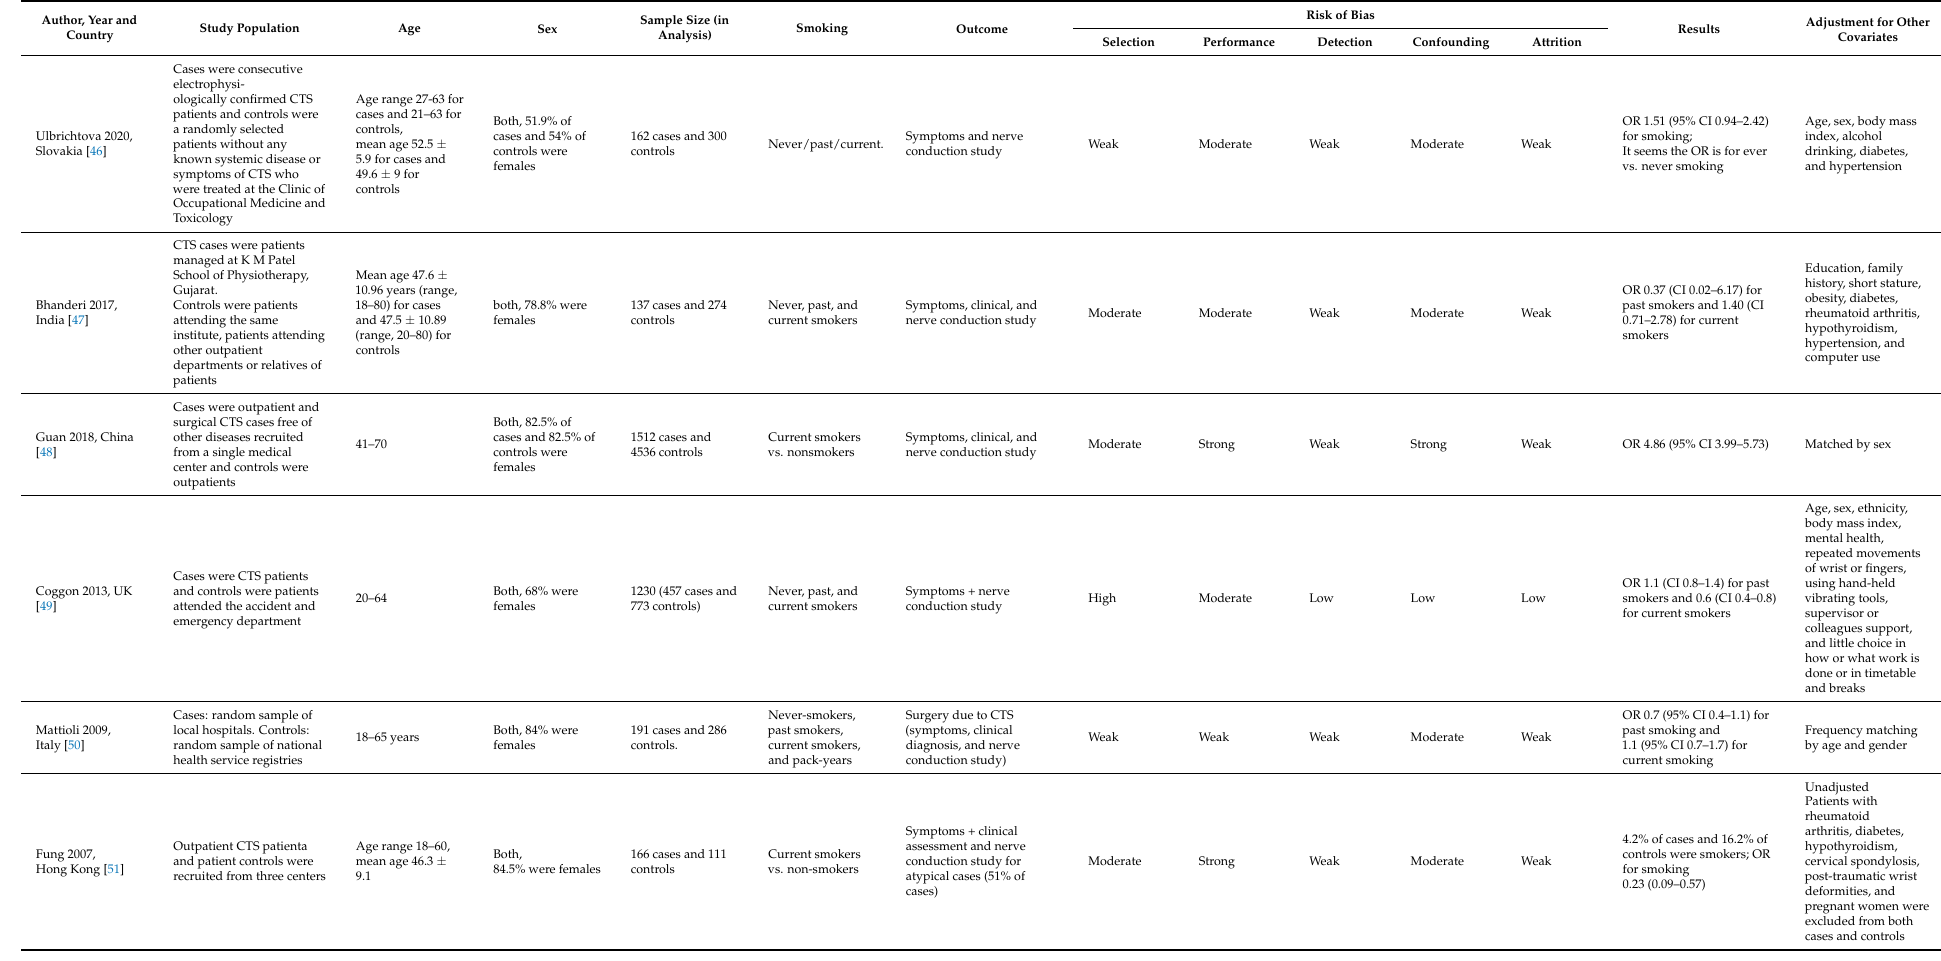
Table A3. Case-control studies included in the